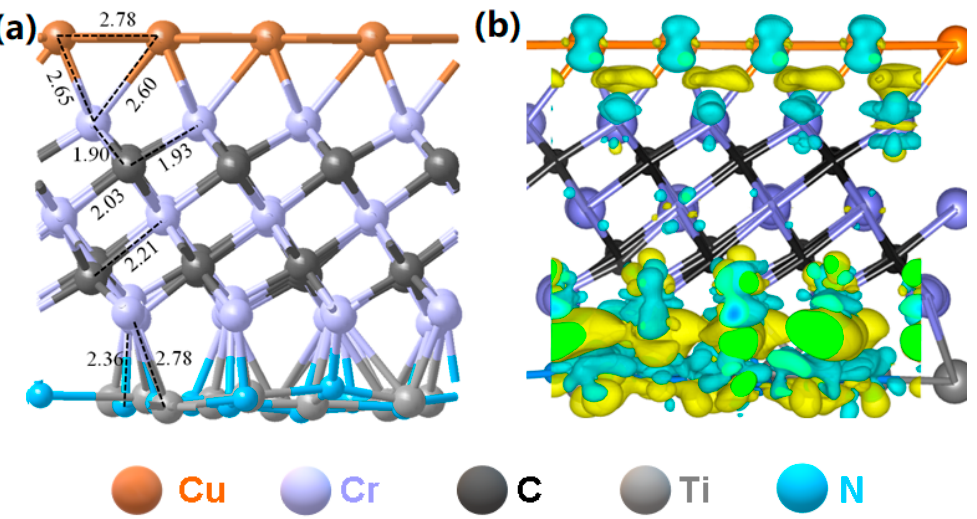
Figure 1. Calculated solid-state properties of Cu / Cr 2 C / TiN. ( a ) Structure and ( b ) charge redistribution (0.06 e / Å 3 ). Color code: yellow and blue show partially negative charge and positive charge, respectively. The unit of bond length is Å.